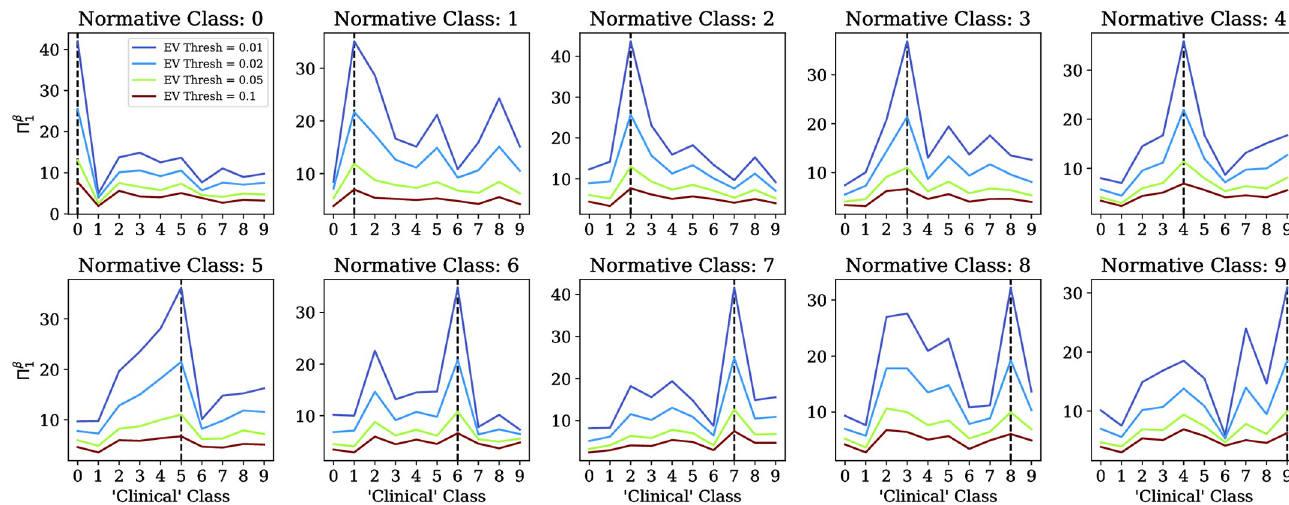
Fig 4. Results of the MNIST experiment. Each plot corresponds to a normative model (cVAE [30, 31]) trained on images from the “normative” digit class , Eq 10), across thresholds c 2 {0.01, 0.02, identified in the title. The x-axes index “clinical” or “target” digit classes. The y-axes plot the β -heterogeneity at q = 1 ( P b 1 0.05, 0.1}. Dashed vertical lines highlight maximal values of P b 1